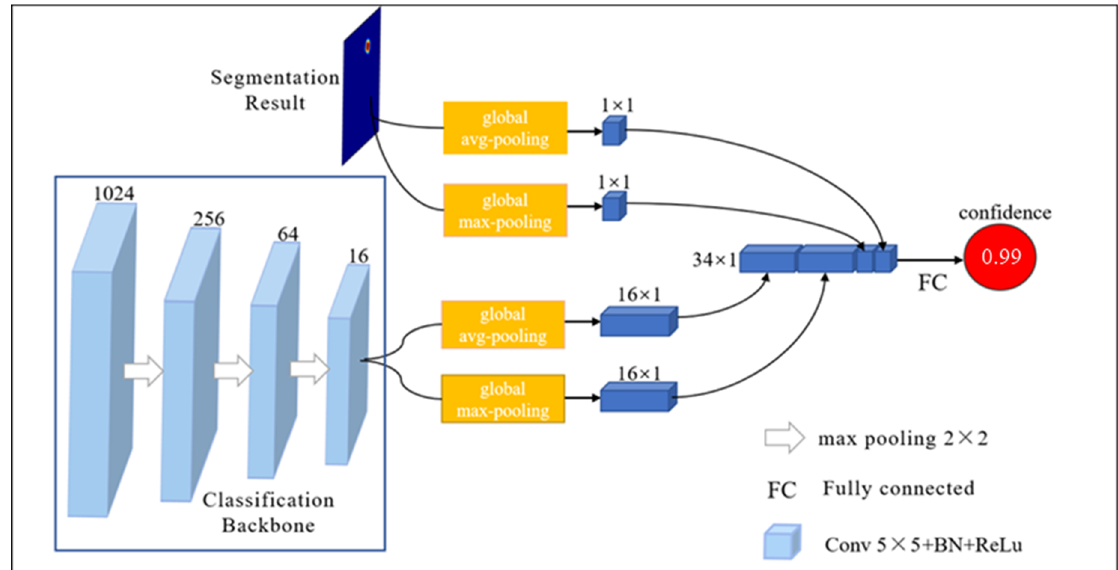
Figure 6. Details of classification subnet. The segmentation result and classification backbone features obtained neurons by the global average and maximum pooling, and the obtained neurons are sent to the full connection layer to obtain the final prediction